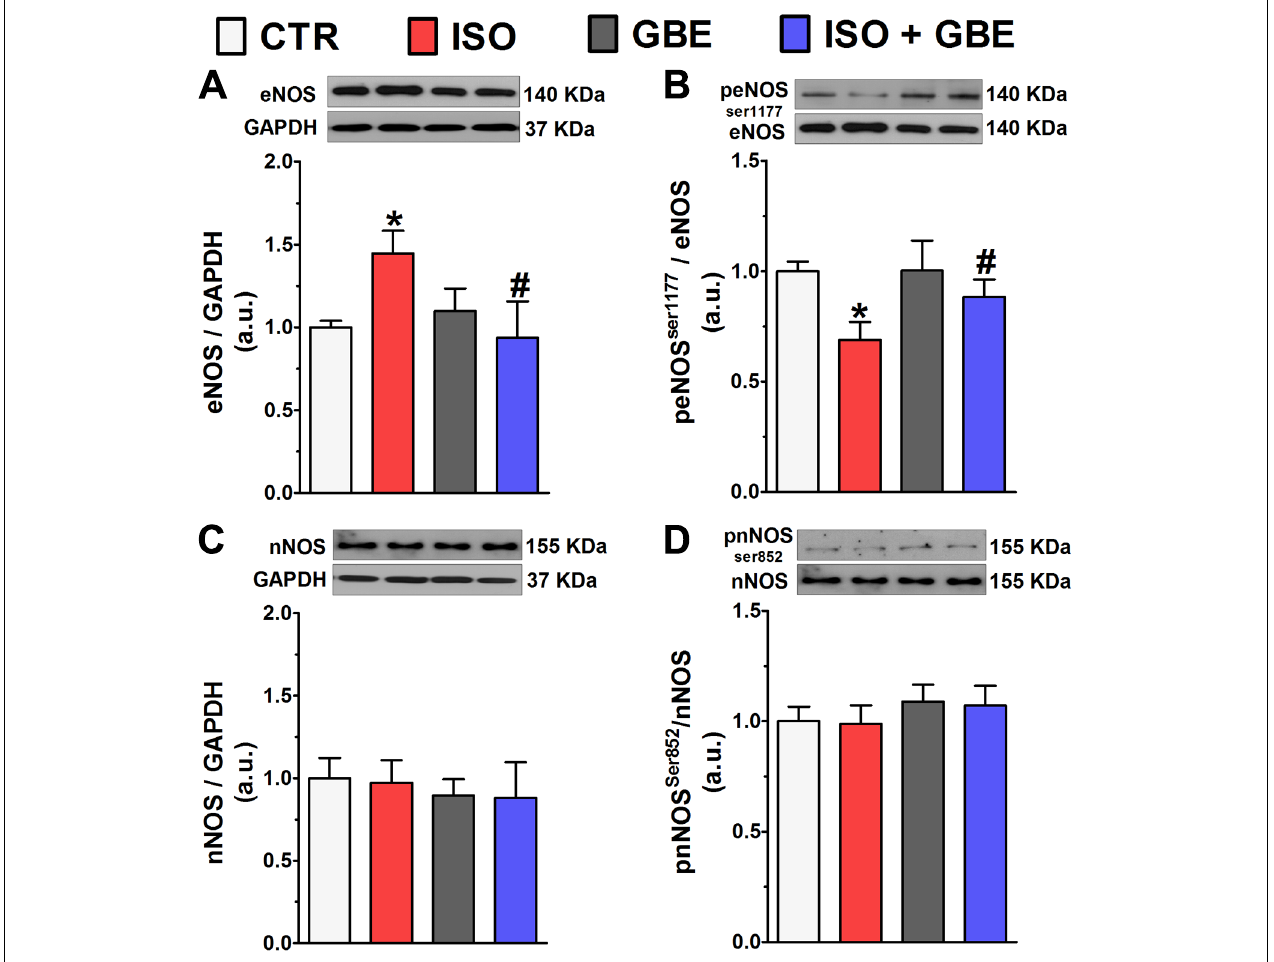
FIGURE 3 | Ginkgo biloba extract restores endothelial nitric oxide synthase (eNOS) protein expression and activity of hypertrophic hearts. ( A–D , top) Representative western blot and quantitative analysis of eNOS (A) , peNOS ser1177 (B) , nNOS (C) , and pnNOS ser852 (D) protein levels. Data are represented as means ± SEM, ( n = 4–6). ∗ p < 0.05 vs. CTR, # p < 0.05 vs. ISO, one-way ANOVA followed by Bonferroni’s